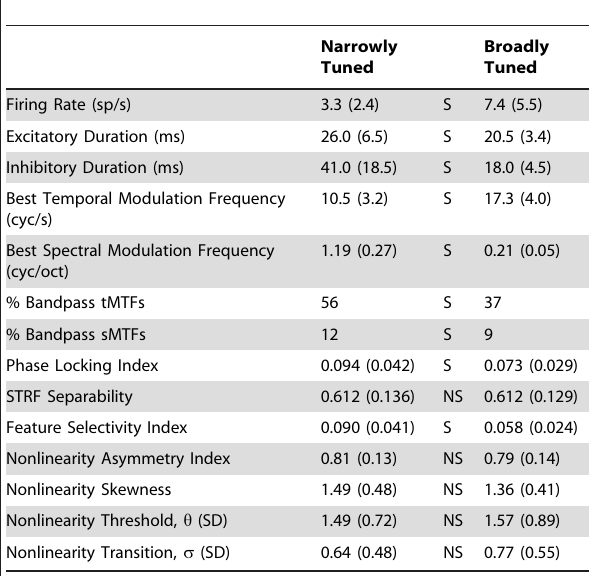
Table 1. Receptive field parameters of Narrowly and Broadly Tuned AI